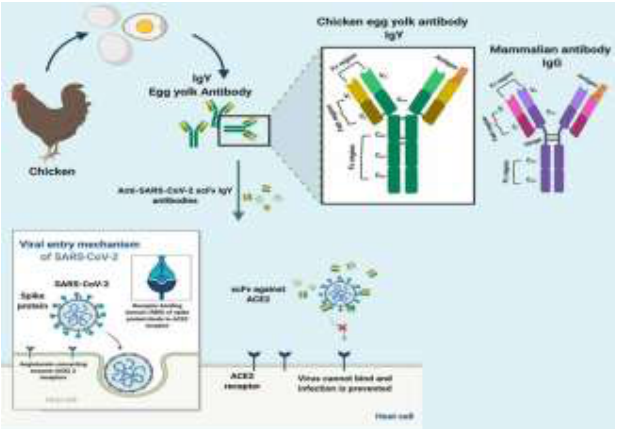
Fig. 2. SARS-Cov-2 Replication Cycle (The figure was made using